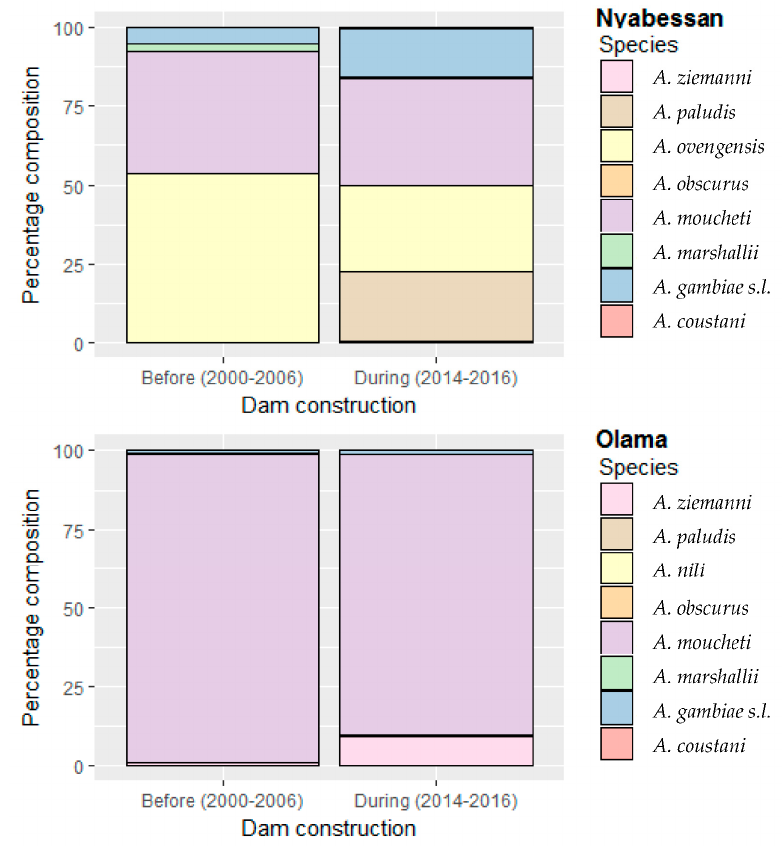
Figure 2. Stacked bar plots showing the percentage composition of anopheline fauna throughout time points in Nyabessan and Olama, before versus during the Memve’ele dam construction.